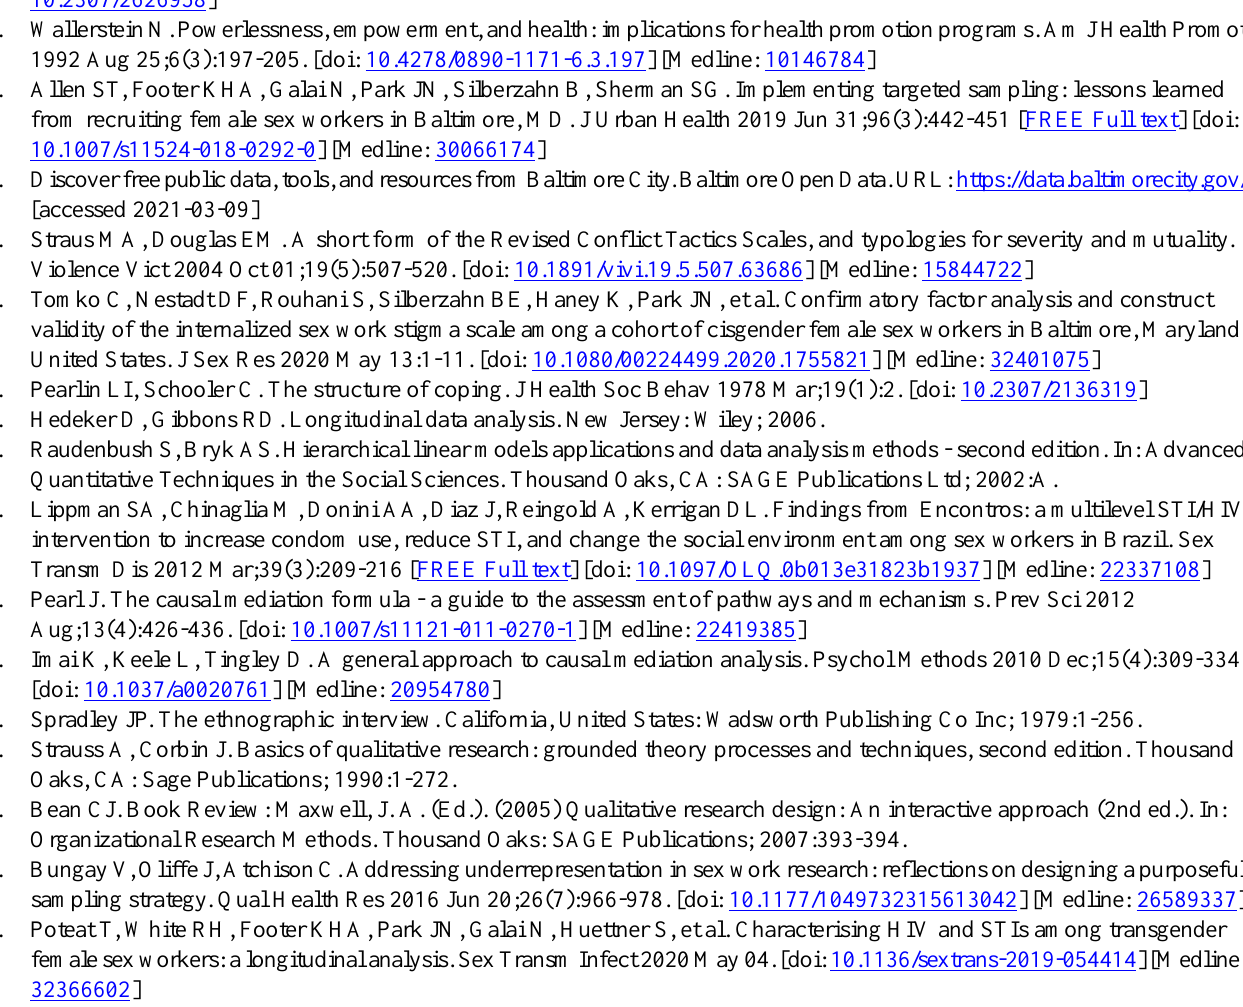
FSW: female sex worker LTFU: lost-to-follow-up RV: recreational vehicle SAPPHIRE: Sex Workers and Police Promoting Health in Risky Environments